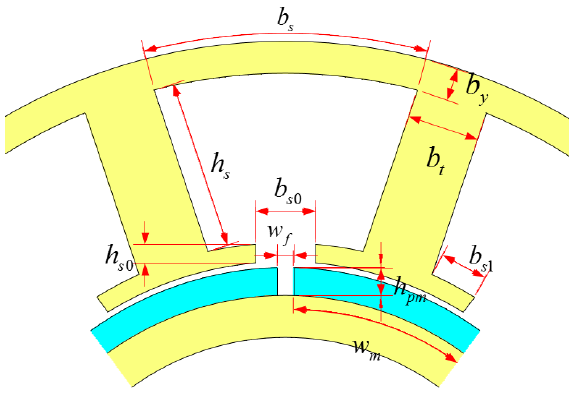
Figure 5. The basic structural parameters of the motor.